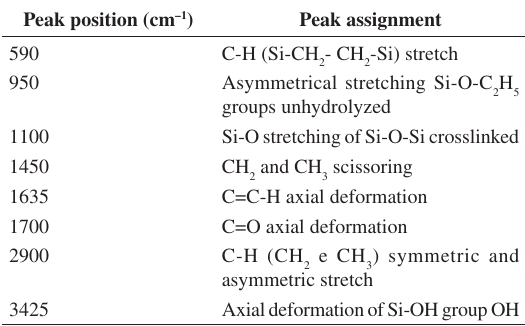
Table 4. FTIR peaks assignment as function of peak position 28 .